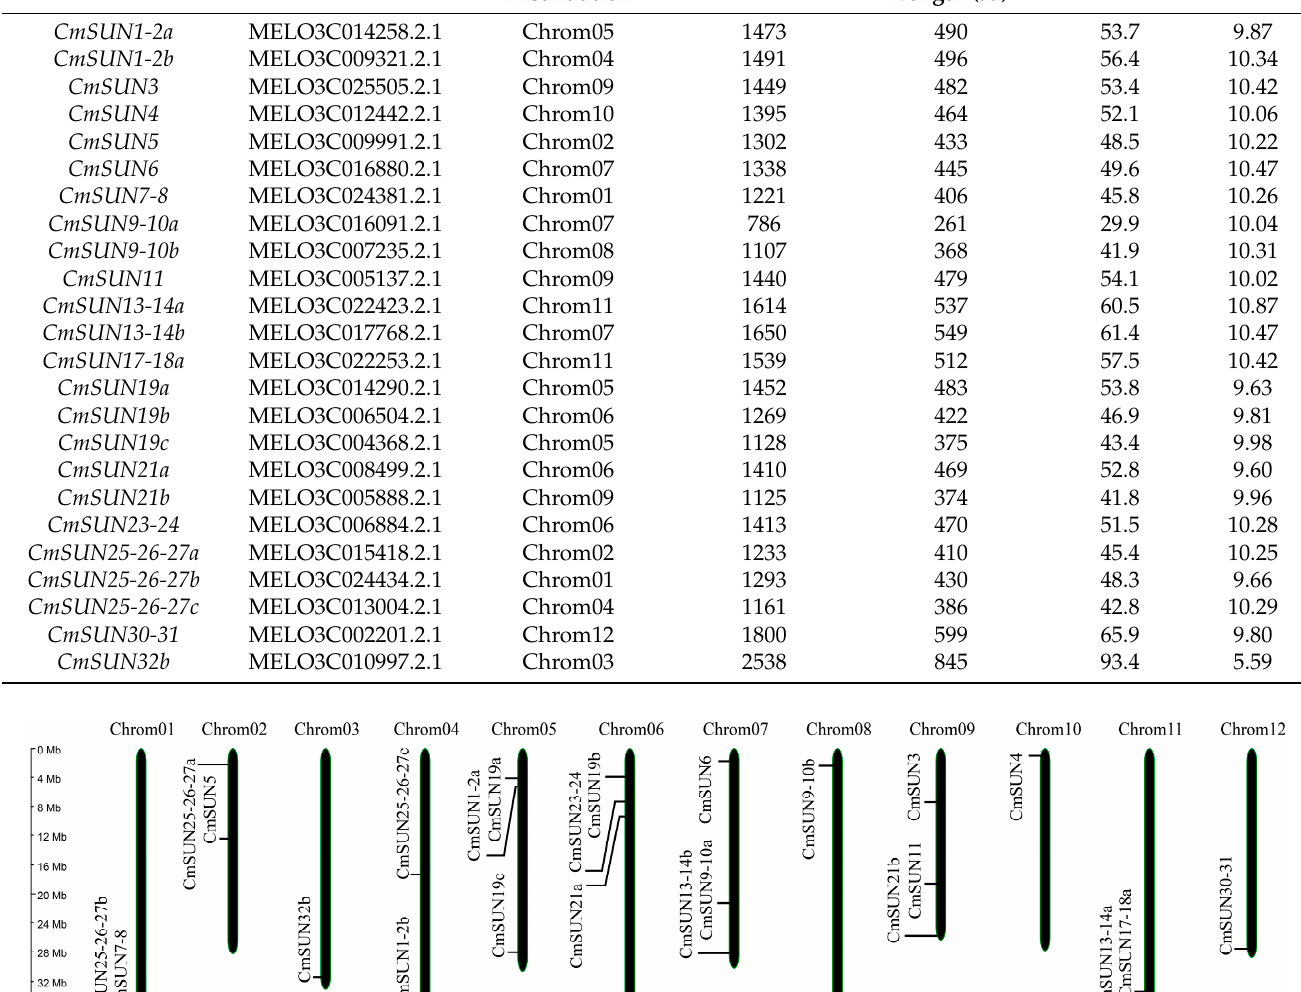
Table 1. Information and physicochemical properties of 24 CmSUN members.